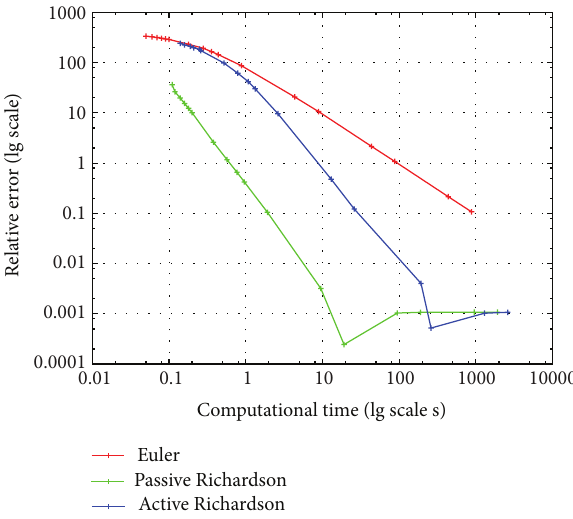
Figure 9: Relative error as a function of computational time for the Euler method without and with passive and active Richardson extrapolation. In the simulation the grid step was Δ𝑥 = 1 and the advection velocity 𝑢 = 0.1 . The reference solution was calculated using Δ𝑡 = 10 −7